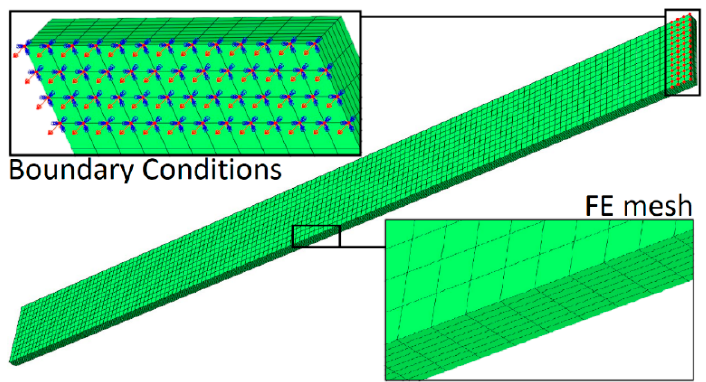
Figure 6. Finite ‐ element (FE) mesh of the discretized bending specimen with position of applied Figure 6. Finite-element (FE) mesh of the discretized bending specimen with position of applied boundary conditions. boundary